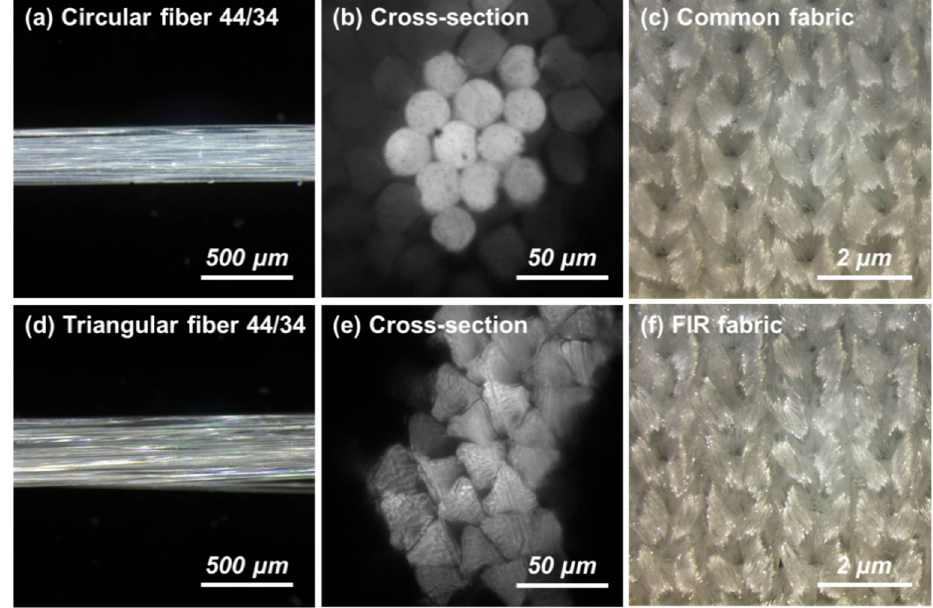
Figure 1. Optical morphologies of ( a ) surface of circular fiber; ( b ) cross-section of circular fiber; ( c ) surface of full needle common fabric with circular fibers; ( d ) surface of triangular fiber; ( e ) cross-section of triangular fiber; ( f ) surface of full needle far-infrared radiation (FIR) fabric with triangular fibers.